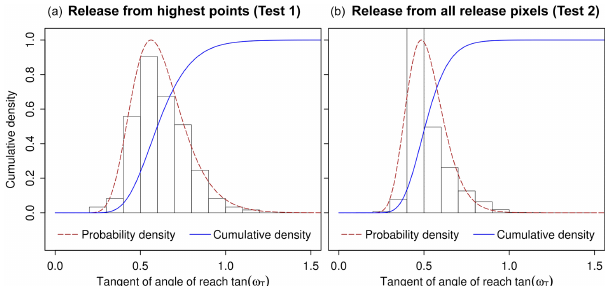
Figure 10. Histograms, probability densities, and cumulative den- sities of ω T of mass movements in the test area in the Kao Ping Watershed. (a) Result for a set of 10 4 random walks started from the highest point of each landslide (test 1). (b) Result for a set of 10 4 random walks started from each pixel within the release areas of all landslides (test